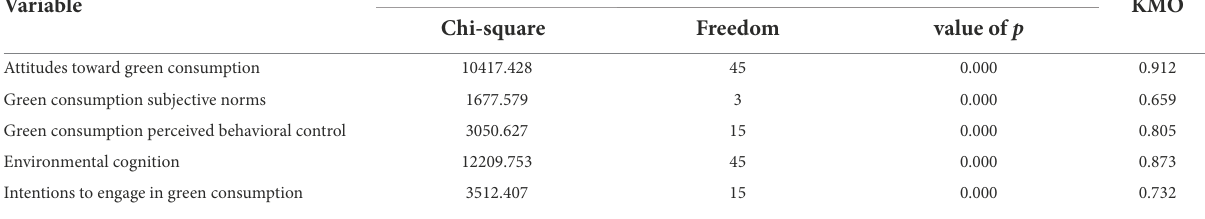
TABLE 2 Reliability test results of the